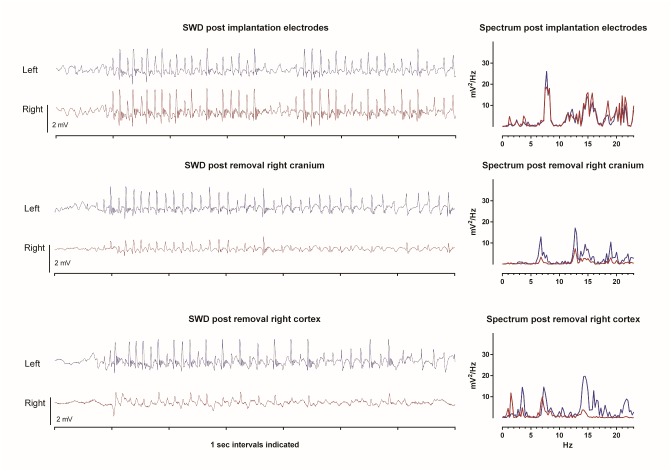
Spike-wave discharges in acute neurolept anesthetized WAG/Rij rats.Example of bilateral differential LPF recording of the left and right hemisphere and spectral plot (1–25 Hz) of a SWD in an acute neurolept anesthetized WAG/Rij rat (for details on electrode position see accompanying text) after the electrodes have been implanted (top). After removal of the right cranium, SWDs with clear spikes and slow waves are seen, albeit with a smaller amplitude both during background and during SWD (middle). The characteristic peak frequency of the SWDs in both hemispheres remains unchanged, as well the presence of its characteristic harmonics. The diminishment of the amplitude at both sides can be best appreciated from the spectral plots, the reduction is largest at the lesioned hemisphere, although the left-right difference was not statistically significant. Bottom: SWD post removal right cortex shows that SWDs are clearly visible in the intact (left) hemisphere, their identification in the right hemisphere is doubtful since they no longer fulfill the criteria of SWDs (van Luijtelaar and Coenen, 1986).